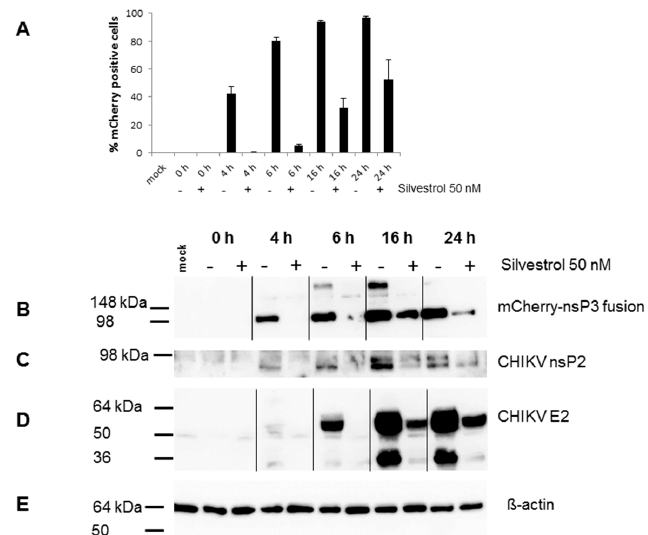
Figure 2. Infection of 293T cells with CHIKV-mCherry in the presence of 50 nM silvestrol. ( A )